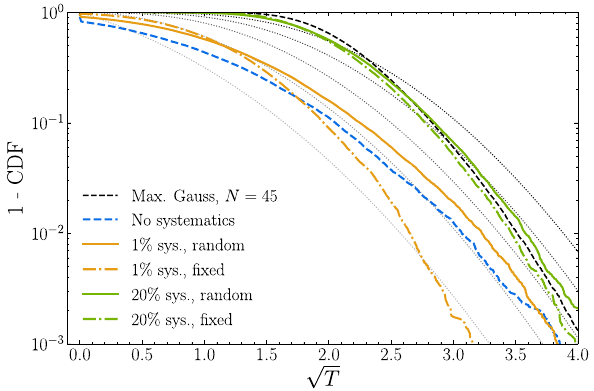
Fig. 3 Impactofasystematicuncertaintyontheoverallnormalization. We show the distribution of the square-root of the test statistic, no systematic uncertainty, 1, and 20% uncertainty. The total number of events is N = 1 . 5 × 10 4 . For the solid curves we randomize the central values for the systematic for each draw of the pseudo-data, whereas for the dash-dotted curves the central value is kept fixed. The black-dashed curves corresponds to the max. Gauss distribution for N = 45. The gray dotted lines show the χ 2 -distributions as the number of degrees of freedom is increased from 1 (lightest gray line to the left) to 5 (darkest gray line to the